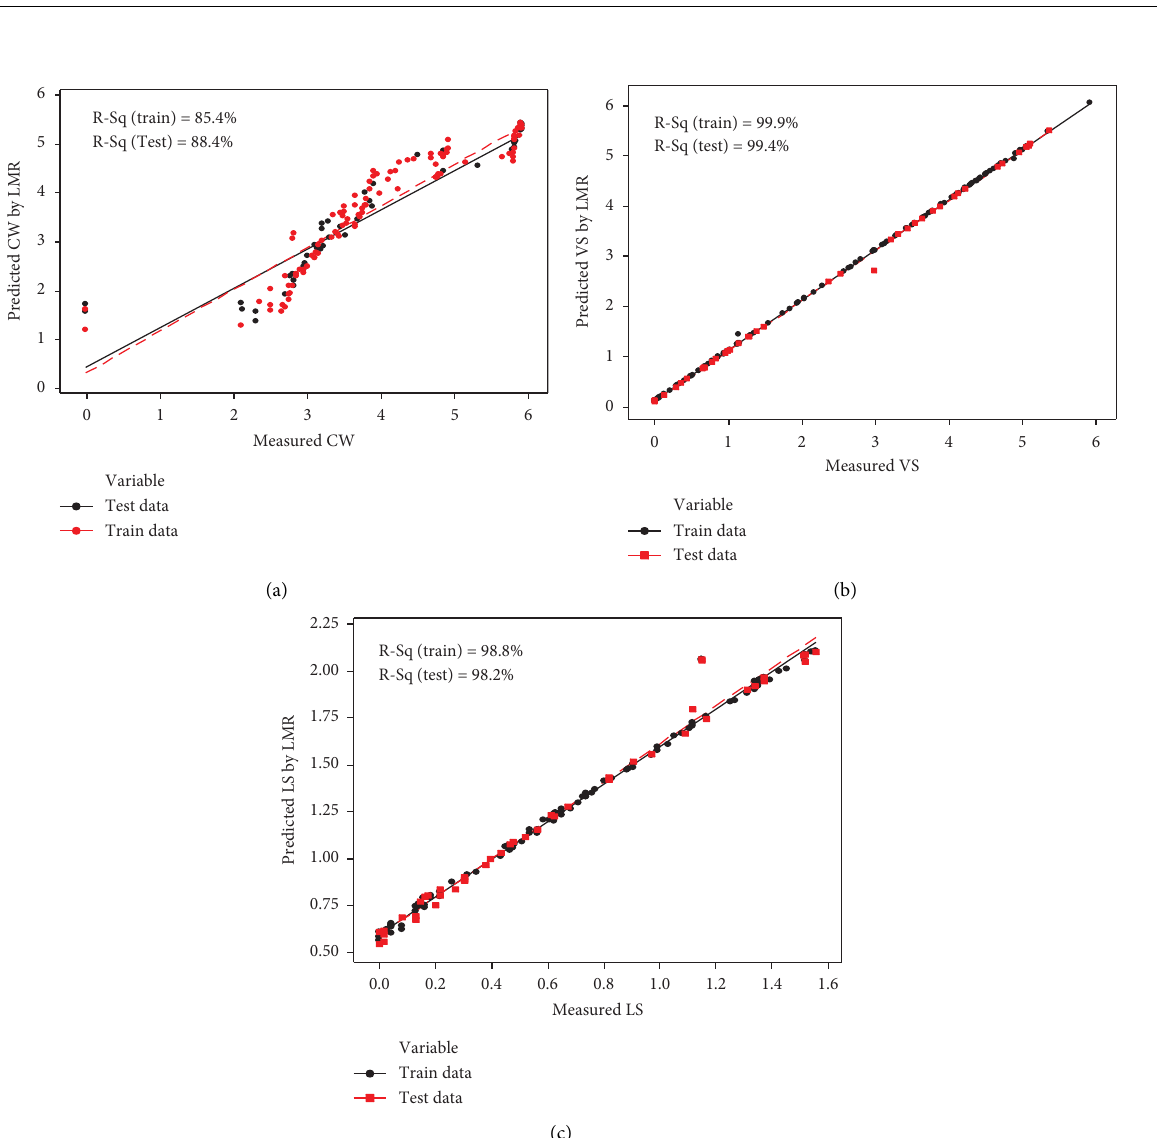
Figure 11: The values of R-squared for MLR models. (a) Crack width (CW), (b) volumetric shrinkage (VS), and (c) linear shrinkage (LS).